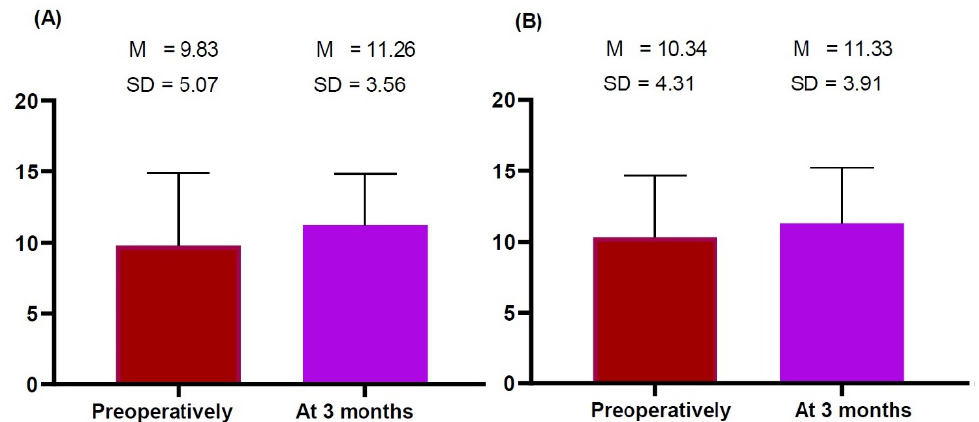
Figure 2. ( A , B ) Differences in the thickness of subcutaneous tissue measured on breast ultrasound preoperatively and 3 months postoperatively. Preoperatively and 3 months postoperatively, the thickness of subcutaneous tissue was measured on both sides of the breast. This showed no significant differences in the thickness of subcutaneous tissue between the preoperative and 3-months postoperative measurements ( p > 0.05). Note: The y -axis indicates measurements.